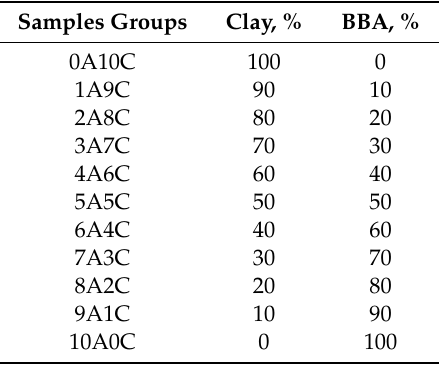
Table 1. Conformed ceramics families with combined percentages of clay and biomass bottom ash. Samples Groups Clay, % BBA, % 0A10C 100 0 1A9C 90